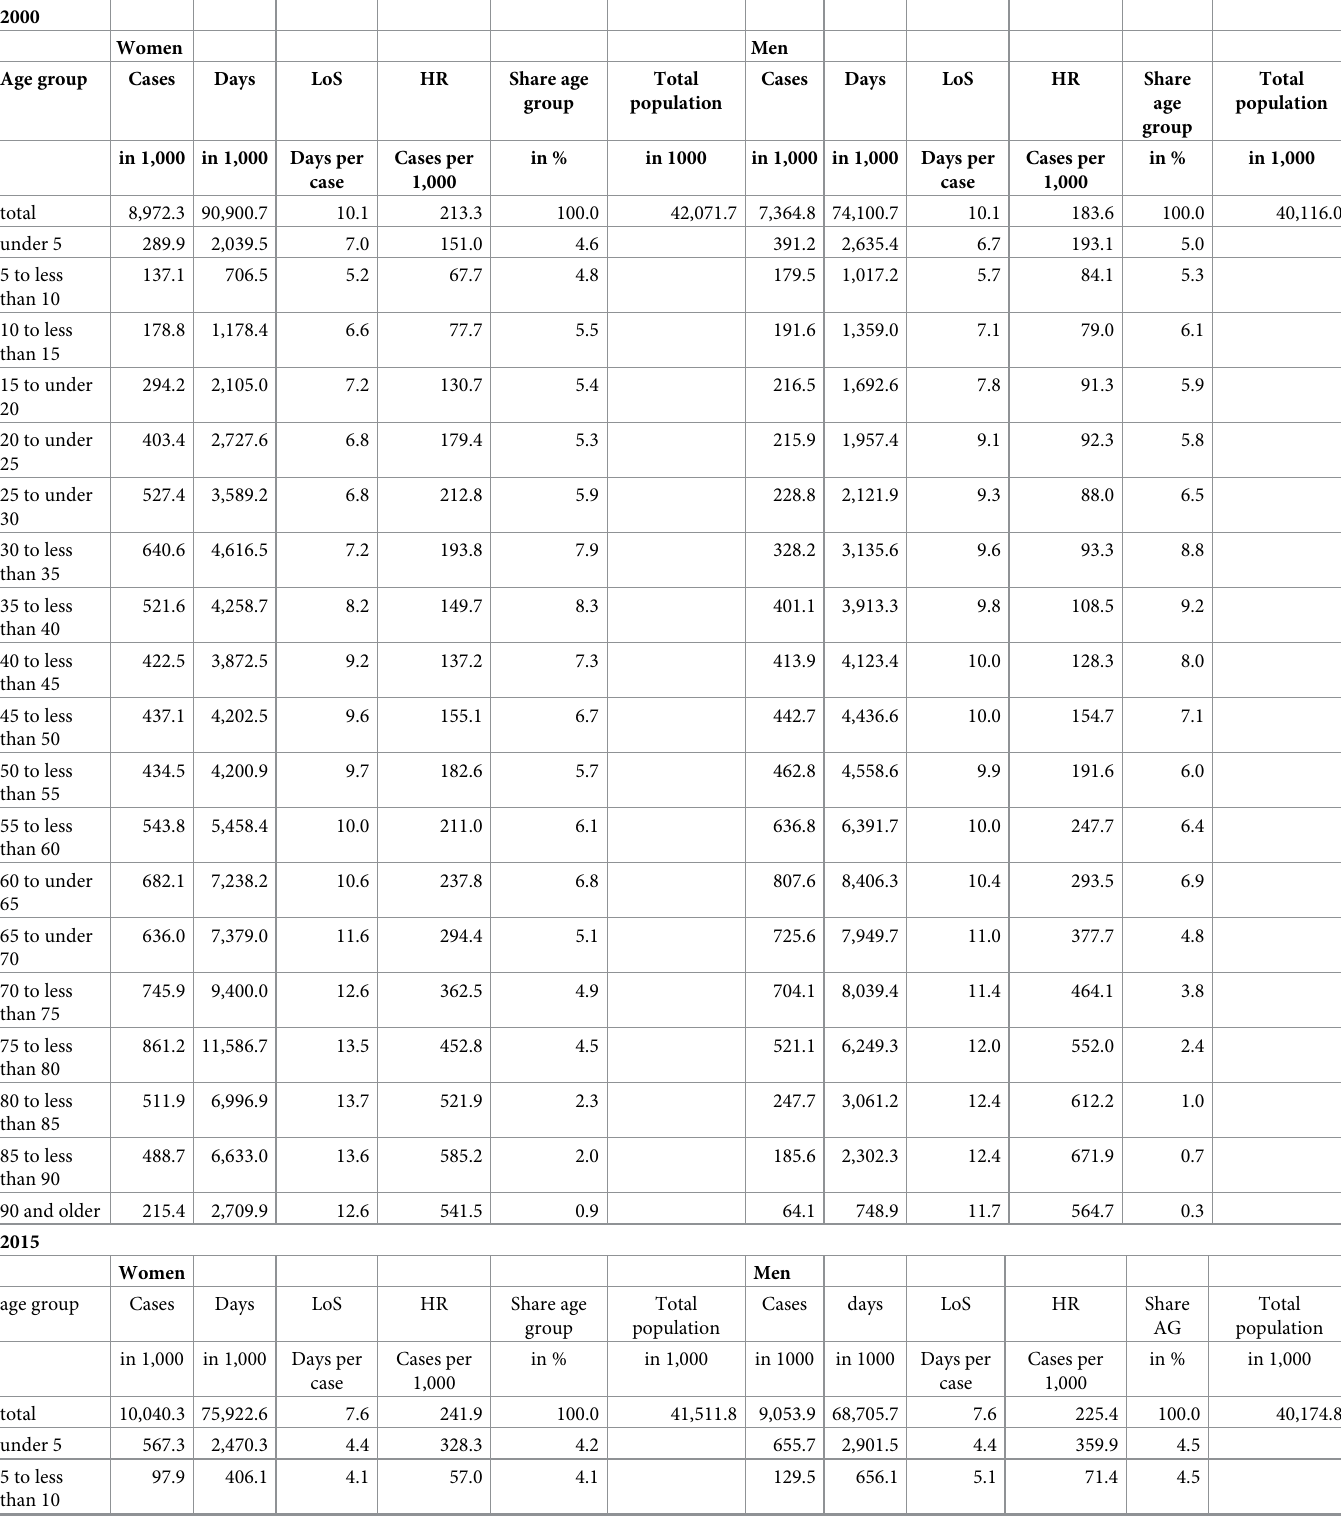
Table 4. Overview of key figures for inpatient care and the population in 2000 and 2015 by gender and age group. 2000